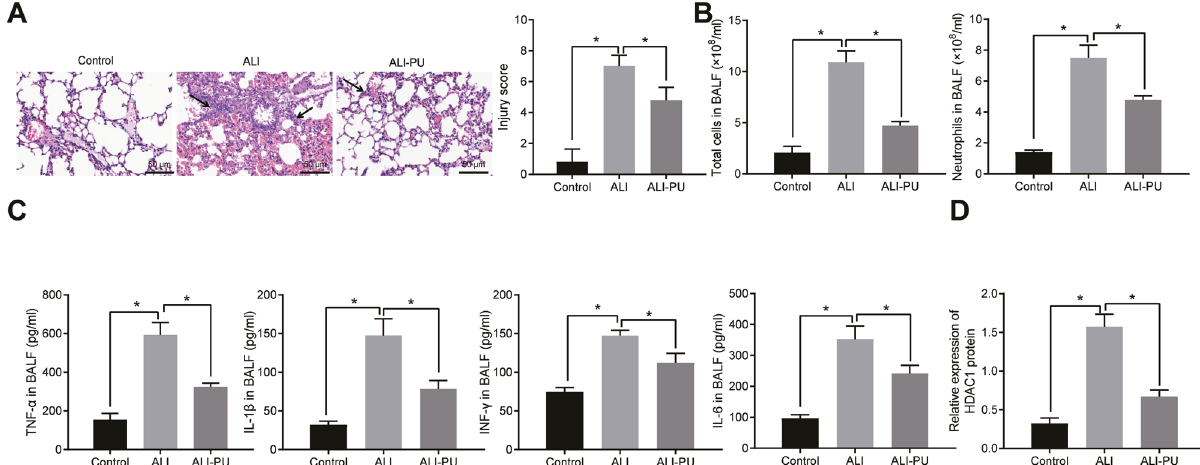
Fig. 1 HDAC1 is expressed at a low level in lung tissues of PU-treated ALI mice. A Pathological changes of lung tissues in animal model, detected by HE staining (×200). B Total number of cells and neutrophils in BALF of animal model. C TNF- α , IL-1 β , INF- γ and IL-6 levels in the BALF of animal model detected by ELISA. D HDAC1 expression in lung tissues of animal model detected by western blot analysis. * p < 0.05. n =